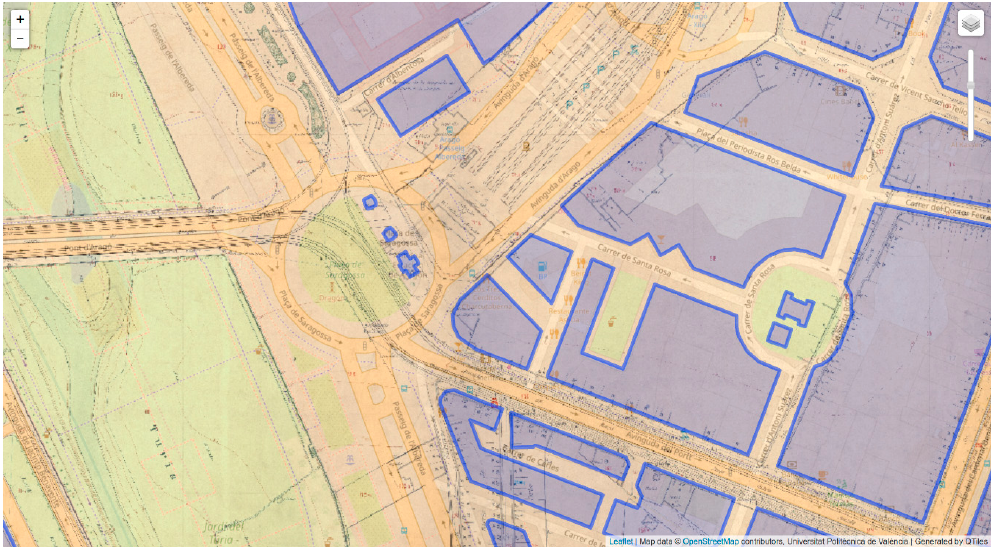
Figure 7. Screenshot of the viewer combining the 1929 map together with OpenStreetMap and vector data. The viewer allows replacing OpenStreetMap layer with an orthoimage. data. The viewer allows replacing OpenStreetMap layer with an